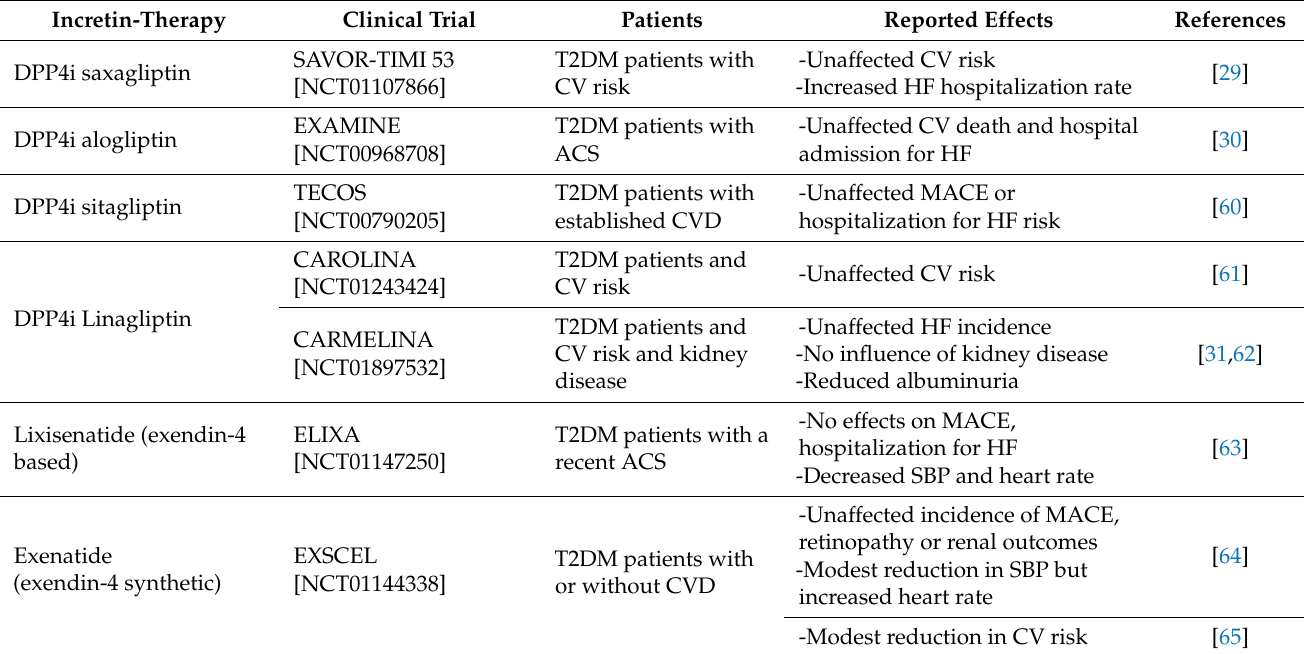
Table 2. Clinical trials of incretin-based